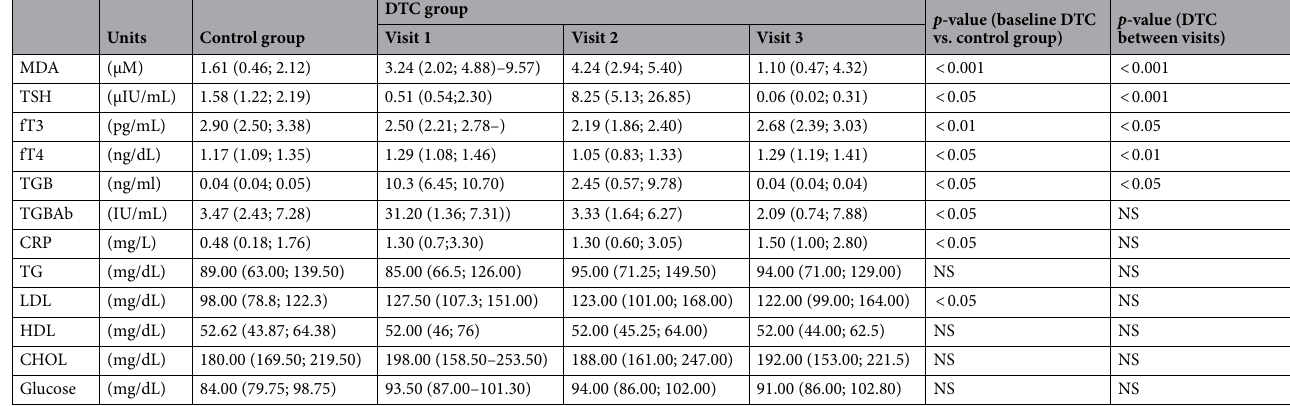
Table 1. Comparison of the biochemical parameters between the control and study groups (median and lower and upper quartiles). Comparison between the study and control groups was performed using a Mann– Whitney U test, and differences between visits among DTC patients were evaluated using a Friedman’s test. CHOL cholesterol, CRP C-reactive protein, DTC differentiated thyroid cancer, fT3 free triiodothyronine, fT4 free thyroxine, HDL high-density lipoprotein, LDL low-density lipoprotein, MDA malondialdehyde, NS not significant, TG triglyceride, TGB thyroglobulin, TGBAb thyroglobulin antibodies, TSH thyroid-stimulating